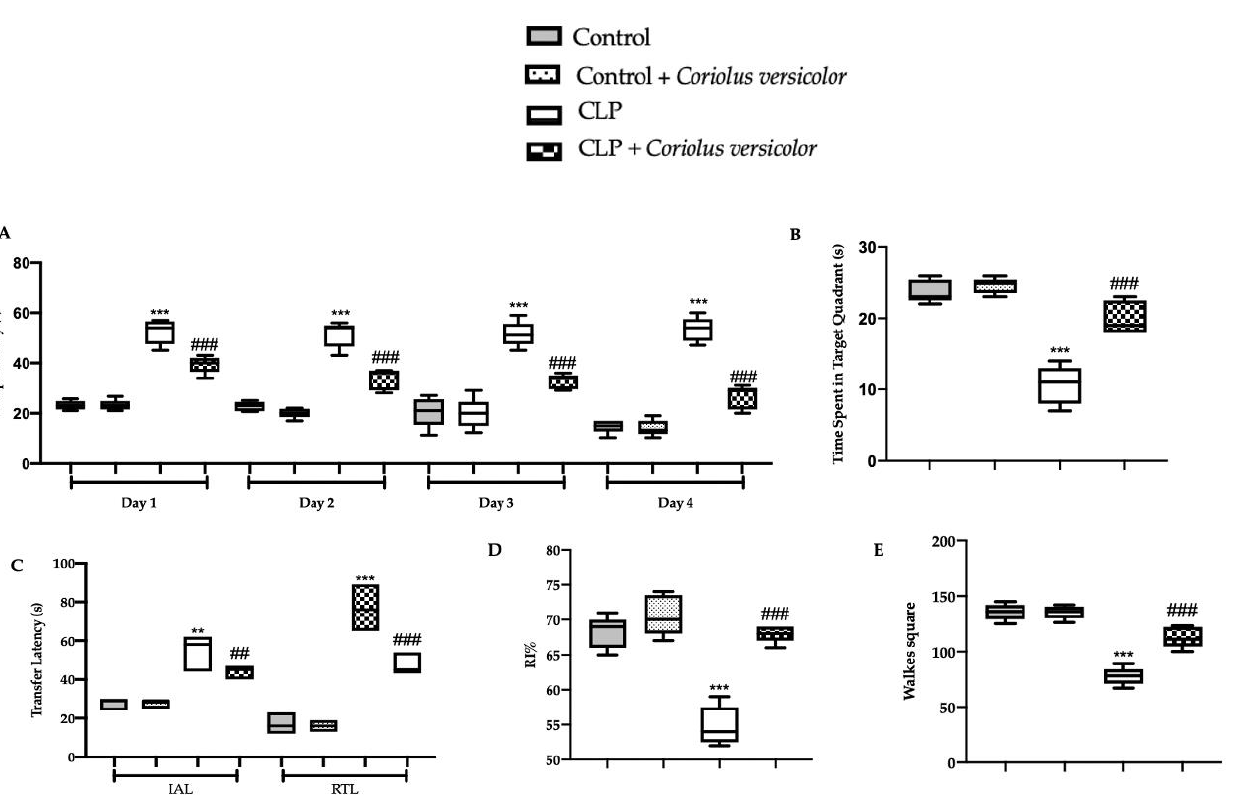
Figure 15. Coriolus versicolor reduced behavioral alterations induced by CLP 28 days after surgery. Morris water maze test: training ( A ), probe trial ( B ); Elevated plus maze test ( C ); Novel object recog- nition test ( D ); Open field test ( E ). ** p < 0.01 vs. control, ## p < 0.01 vs. CLP, *** p < 0.001 vs. control, ### p < 0.001 vs. CLP.